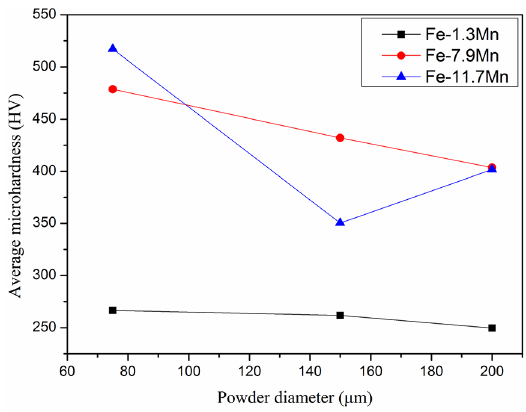
Figure 3. Micro-hardness of Fe-1.3, 7.9, 11.7Mn alloy